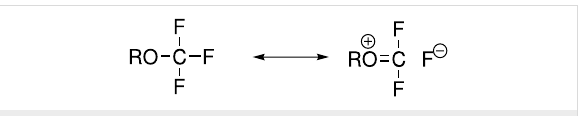
Figure 2: Mesomeric structures of the OCF 3 -group.